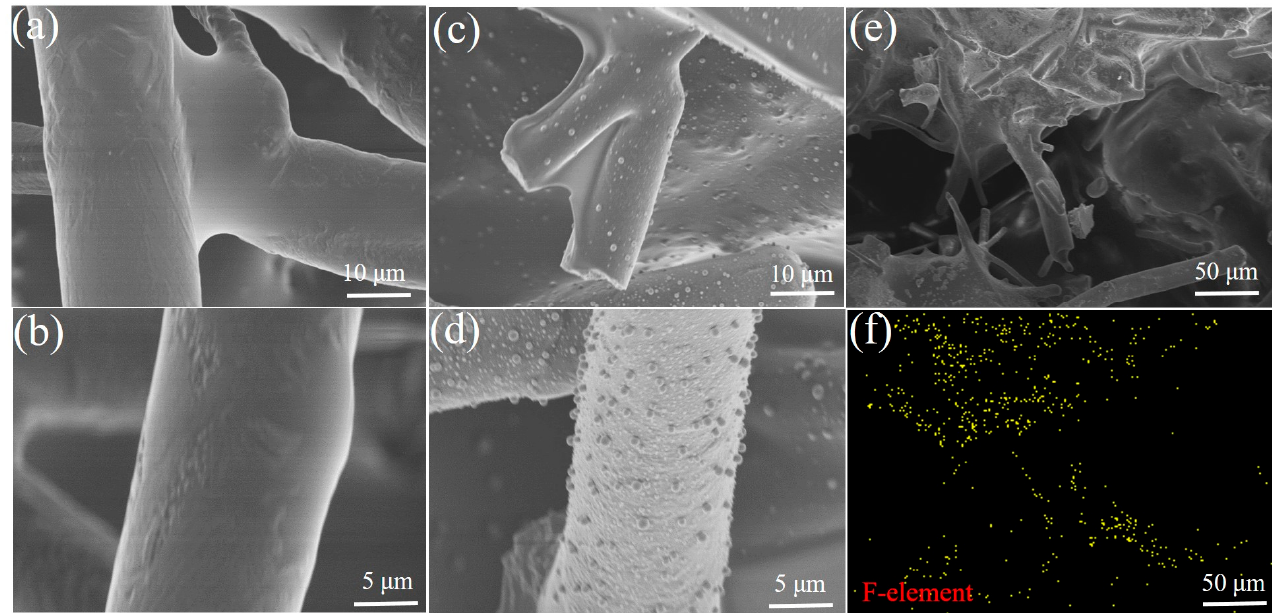
Figure 2. SEM and EDS images of ceramic membrane: ( a , b ) SEM of unmodified ceramic membrane; ( c , d ) SEM of PDMS-ceramic membrane; ( e ) SEM of PTFE-ceramic membrane; and ( f ) EDS mapping of PTFE-ceramic membrane.